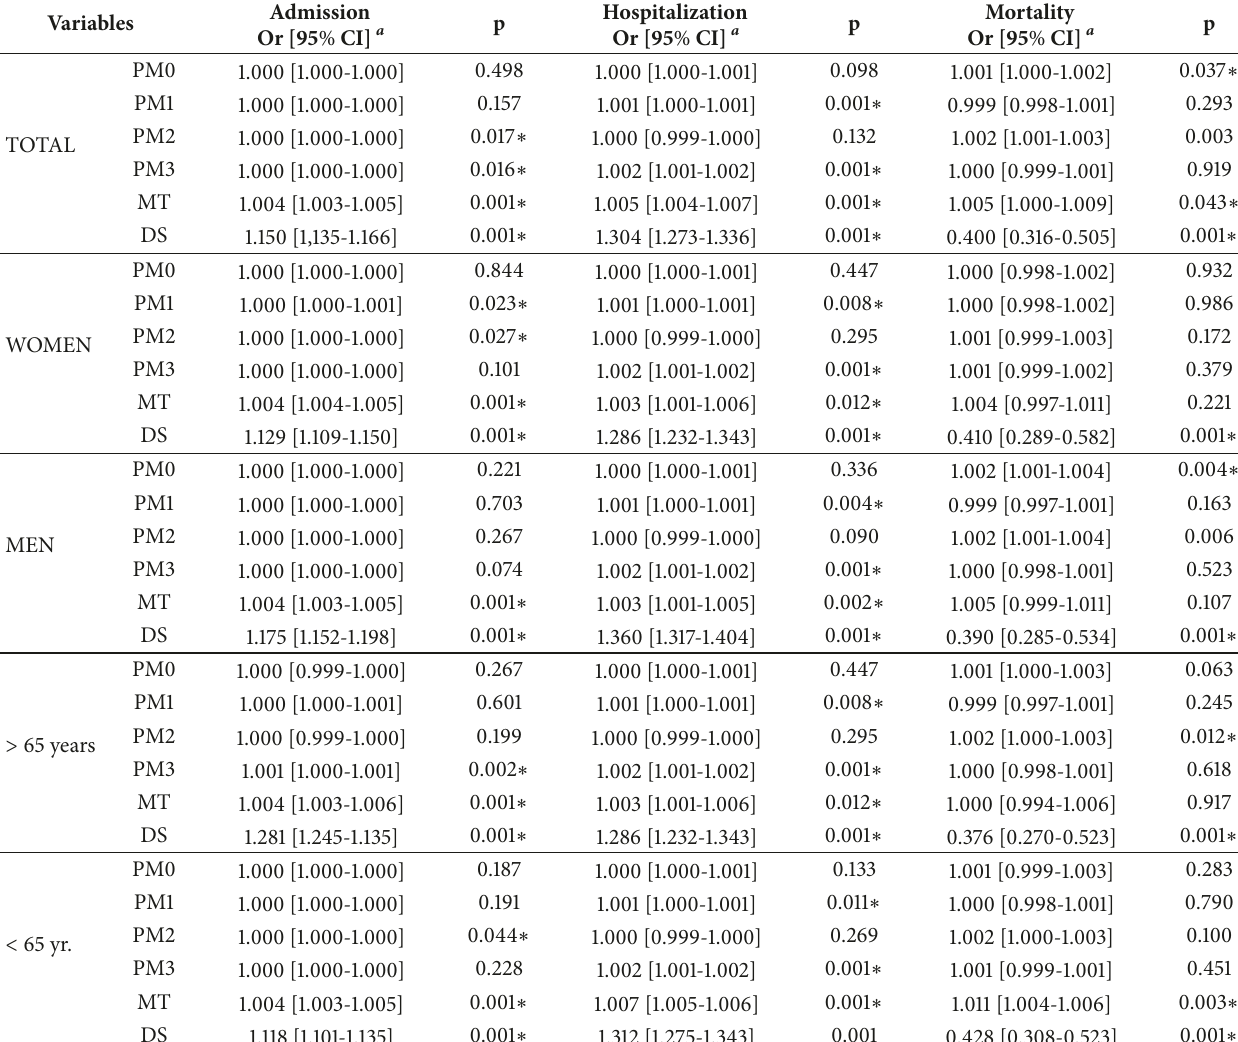
Table 3: Results of generalized additive Poisson models for predicting the number of emergency department visits and hospitalization due to ACS.